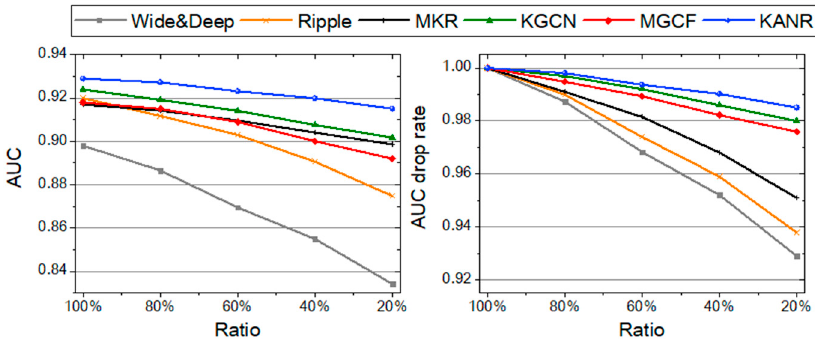
Figure 5. Performance analysis of the model in a cold start scenario.